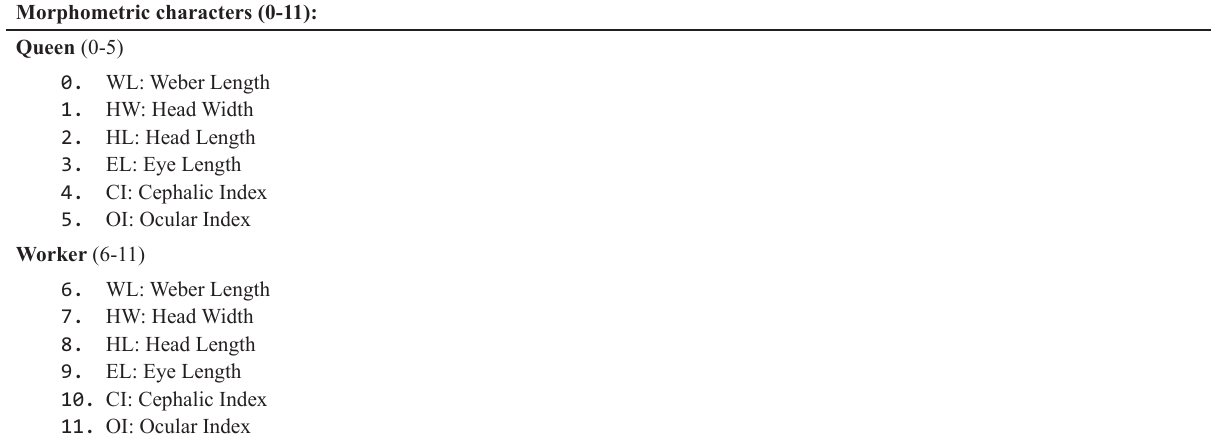
Table 1. List of characters and states (only for discrete characters) used in the phylogenetic